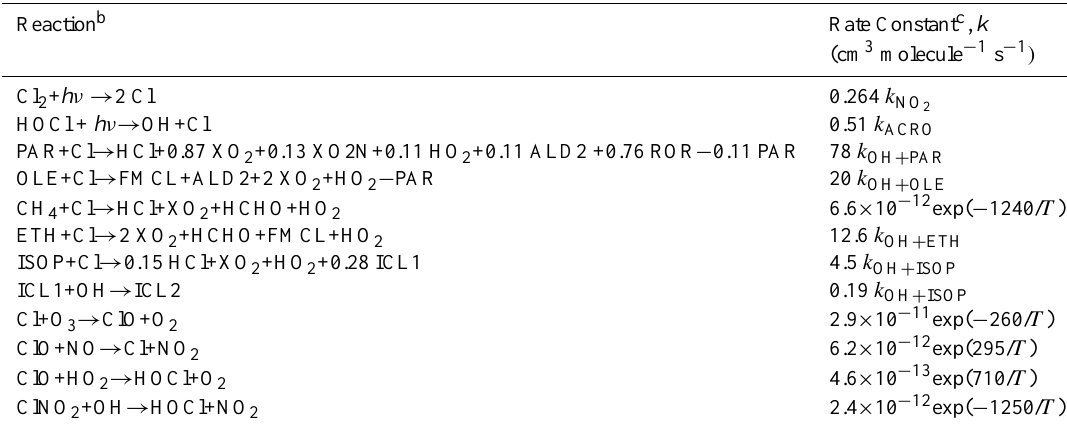
Table 1. Chlorine reactions with importance to tropospheric gas-phase chemistry a .